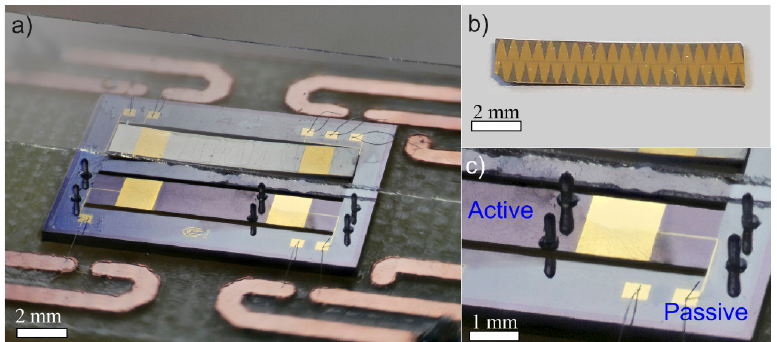
Figure 5. ( a ) Photograph of a dice containing a pair of fabricated motors with attached legs, wire bonded to a printed circuit board (PCB). In the experimental setup, a gold-patterned slider was placed on top of the motor, laying on the legs, and constrained to a lane by a vertical glass slice. ( b ) Micrograph of the silicon slider with a gold pattern deposited on top. ( c ) Detailed micrograph of the two pairs of 3D-printed legs: an active pair attached to the motor surface and a passive pair attached to the device frame.